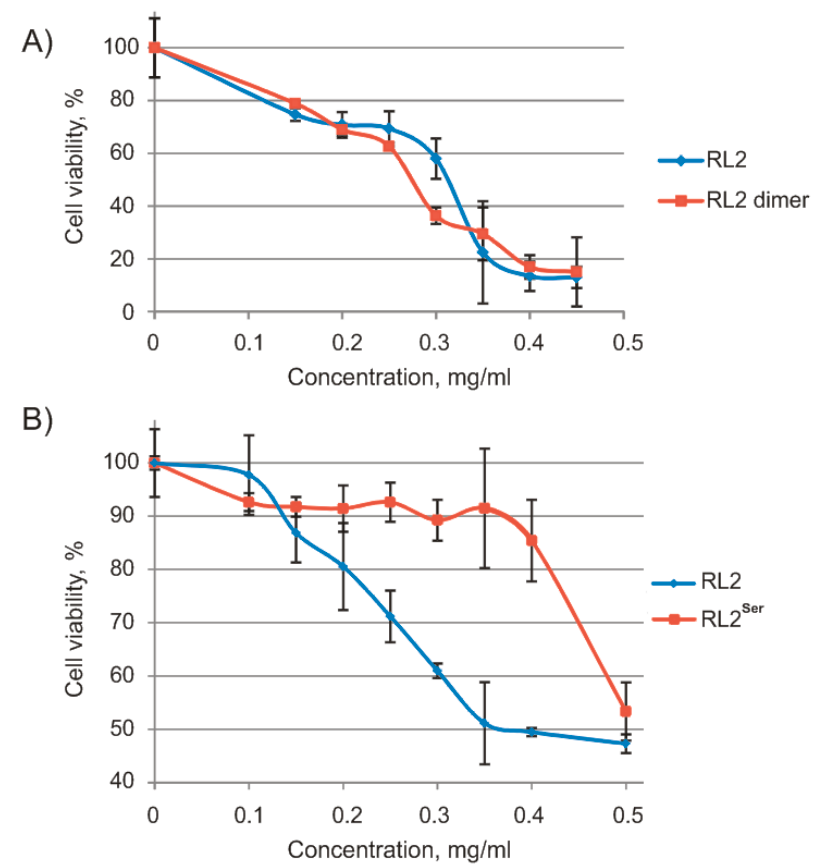
Figure 2. Viability of human cancer cells treated with RL2, dimeric RL2, and RL2 Ser for 48 h (MTT assay). ( A ) A549 cells treated with di ff erent RL2 or RL2 dimer concentrations; ( B ) MDA-MB-231 cells assay). ( A ) A549 cells treated with different RL2 or RL2 dimer concentrations; ( B ) MDA-MB-231 treated with di ff erent concentrations of RL2 and RL2 Ser . Di ff erences between the means control and experimental groups of MDA-MB-231 cell viability are statistically significant in p <